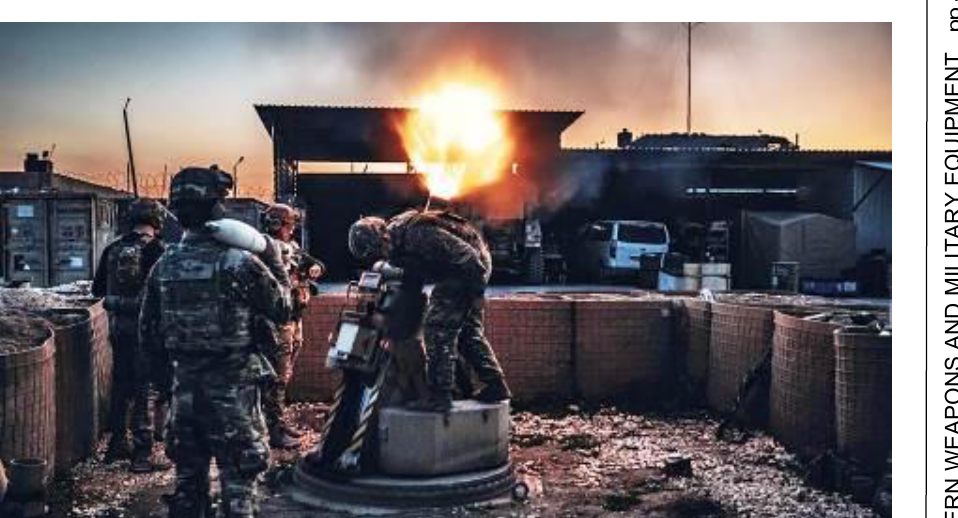
точкаша Stryker